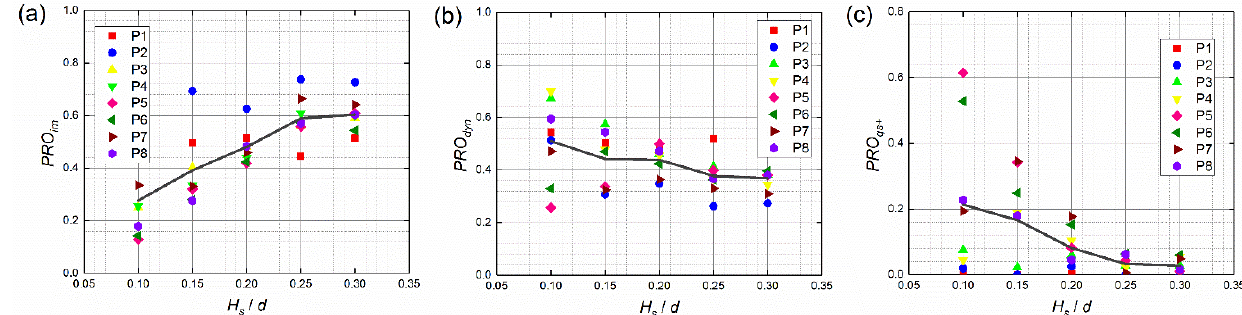
Figure 11. Influence of relative wave height on the probabilities of three types of wave impact on horizontal slab for structural clearance of −0.02 m (trials T11–T15): ( a ) impulsive probability PRO im ; ( b ) dynamic probability PRO dyn ; ( c ) quasi-static probability PRO qs+ .